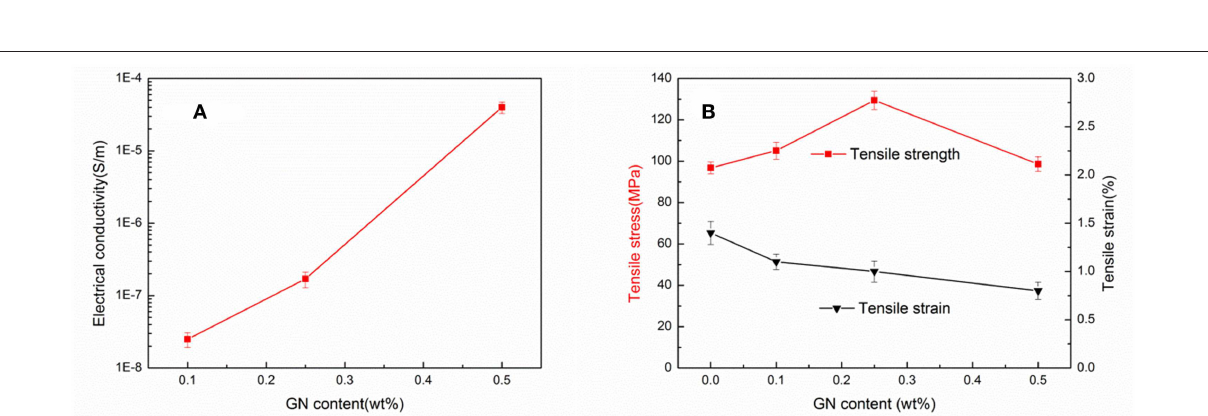
FIGURE 4 | SEM images of CNW adsorption on GN sheets in CNW/GN composite films at the GN content of 0.5 wt%: (A) at low magnification of 20,000 × and (B) at high magnification of 60,000 × .